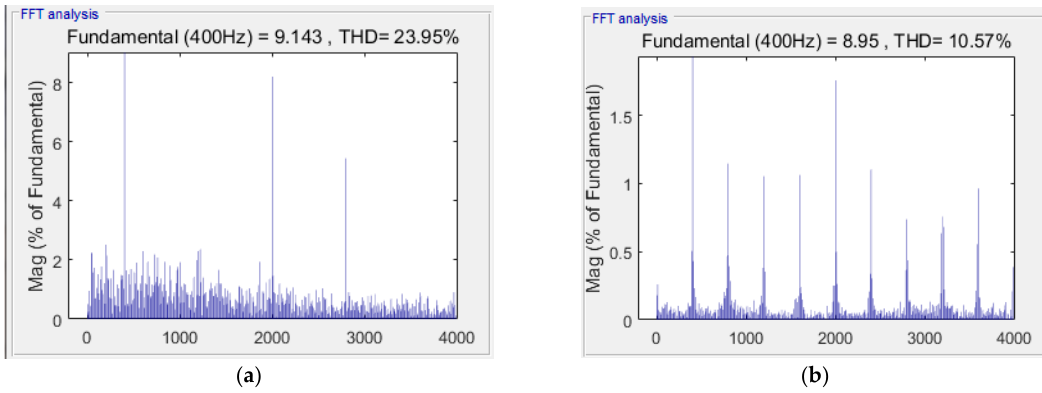
Figure 8. The harmonic component of input current. ( a ) Traditional MPDPC; ( b ) MPDPC with Bayesian